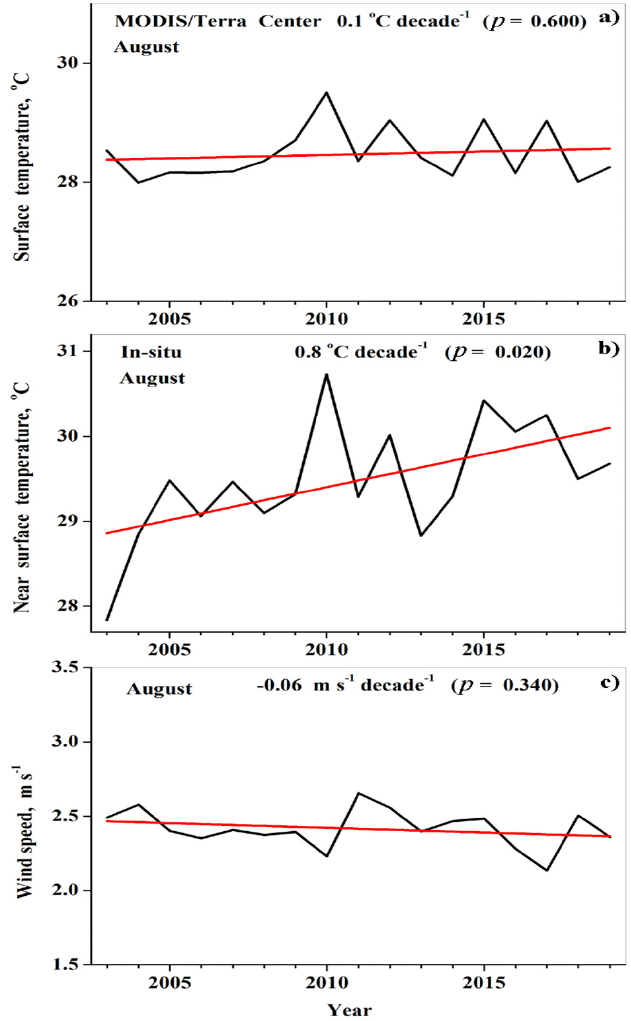
Figure 16. Year-to-year variations of ( a ) MODIS/Terra SWT at a specified place near the Kinneret center, ( b ) in-situ measurements of near surface water temperature at the same place, and ( c ) wind speed taken at the Zemah meteorological station, in August, during the 17-year period (2003–2019). The straight red lines designate linear fits.